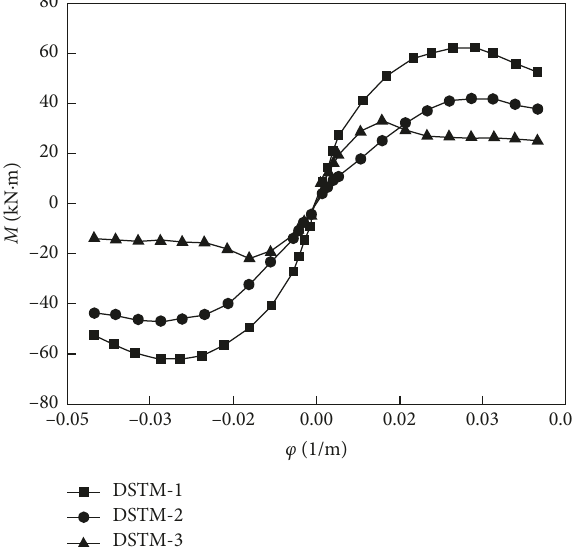
Figure 6: M - φ skeleton loops of